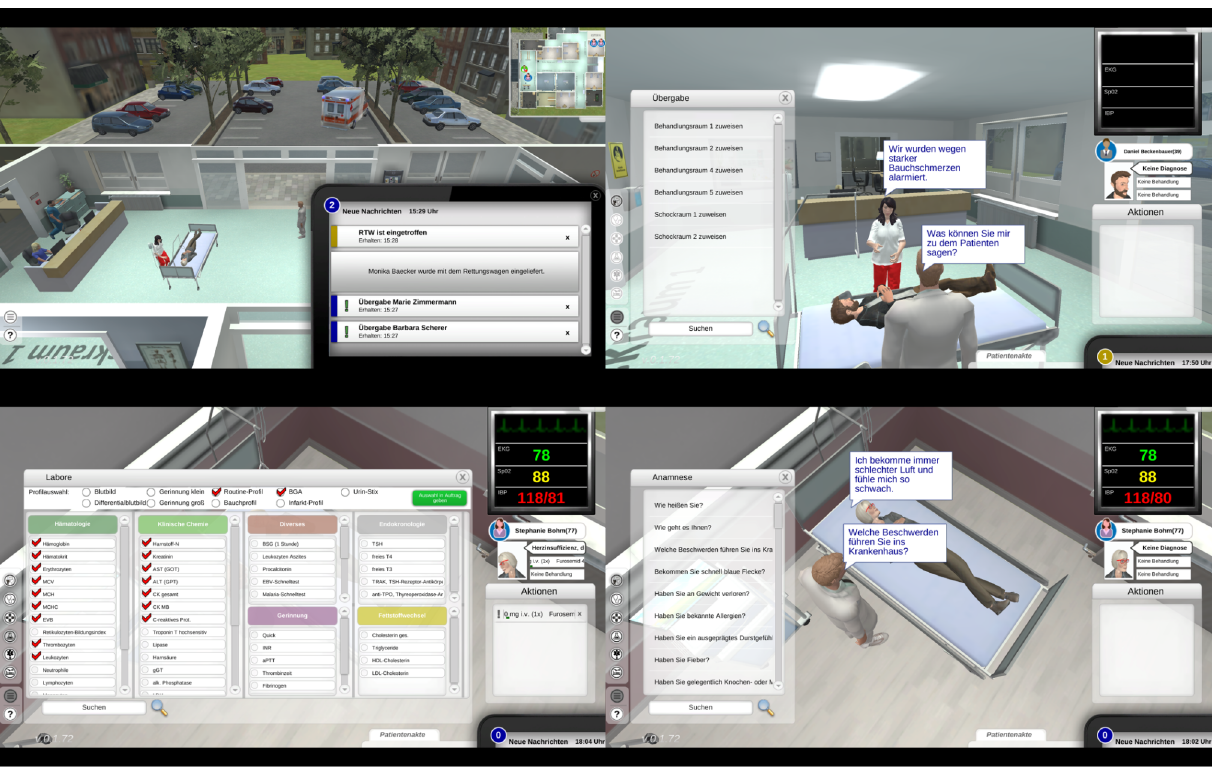
Fig 1. Screen shots of EMERGE. Top left, pager messages a new patient´s arrival. Top right, paramedic provides handoff information. Lower left, selection menu for laboratory tests. Lower right, selection menu for medical history. Graphics by PatientZero Games GmbH.